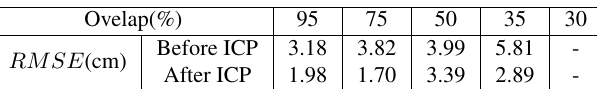
Table 2. Comparison of different